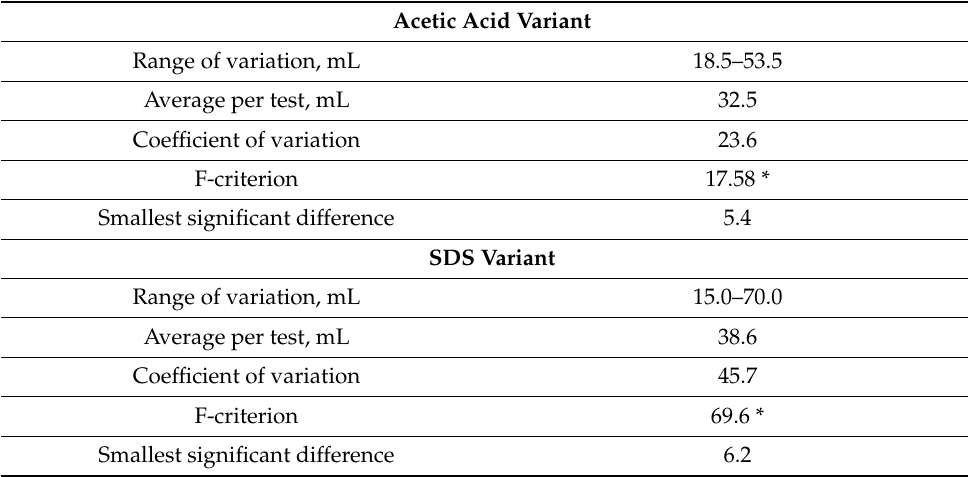
Table 2. Statistical differentiation of maize samples by the sediment